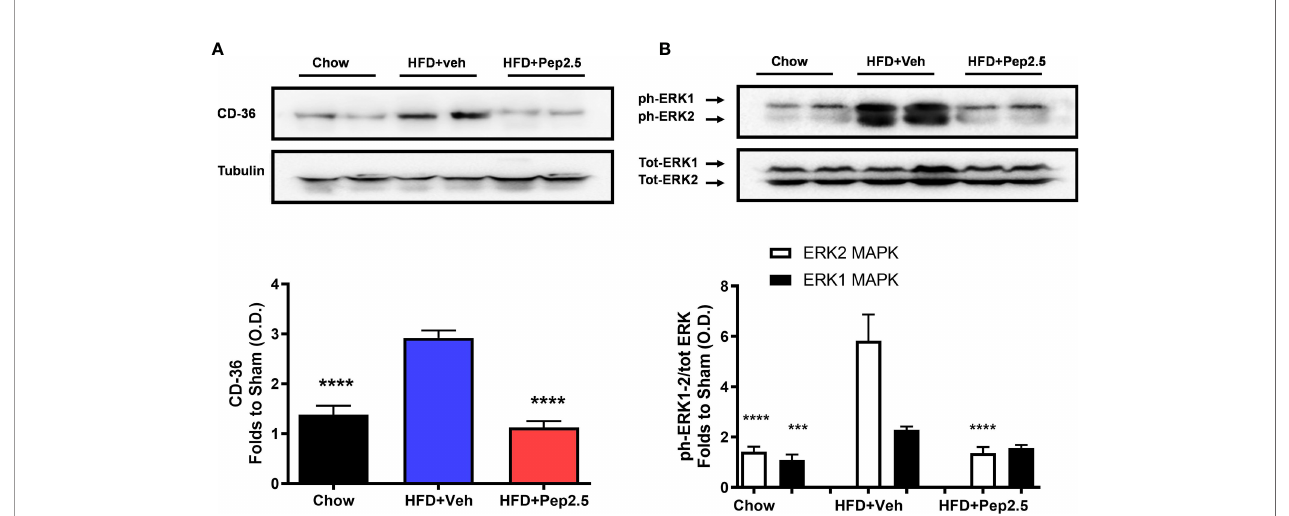
FIGURE 7 | Peptide 19-2.5 reduces CD36 expression and the activation of ERK in the liver of HFD-fed mice. Liver samples were collected at the end of the experiment and the expression of CD36 and the phosphorylation of ERK1/2 were assessed. Densitometry analysis of the bands is expressed as relative optical density (O.D.) of (A) CD36 expression, corrected against tubulin and normalized using the related chow bands; (B) phosphorylation of ERK1/2 corrected to the corresponding total ERK1/2 content and normalized using the related chow band. Data was analyzed by one-way ANOVA, with Bonferroni post-hoc test. Data are expressed as mean ± SEM; n = 8 per group. ***P < 0.001 and ****P < 0.0001 vs.